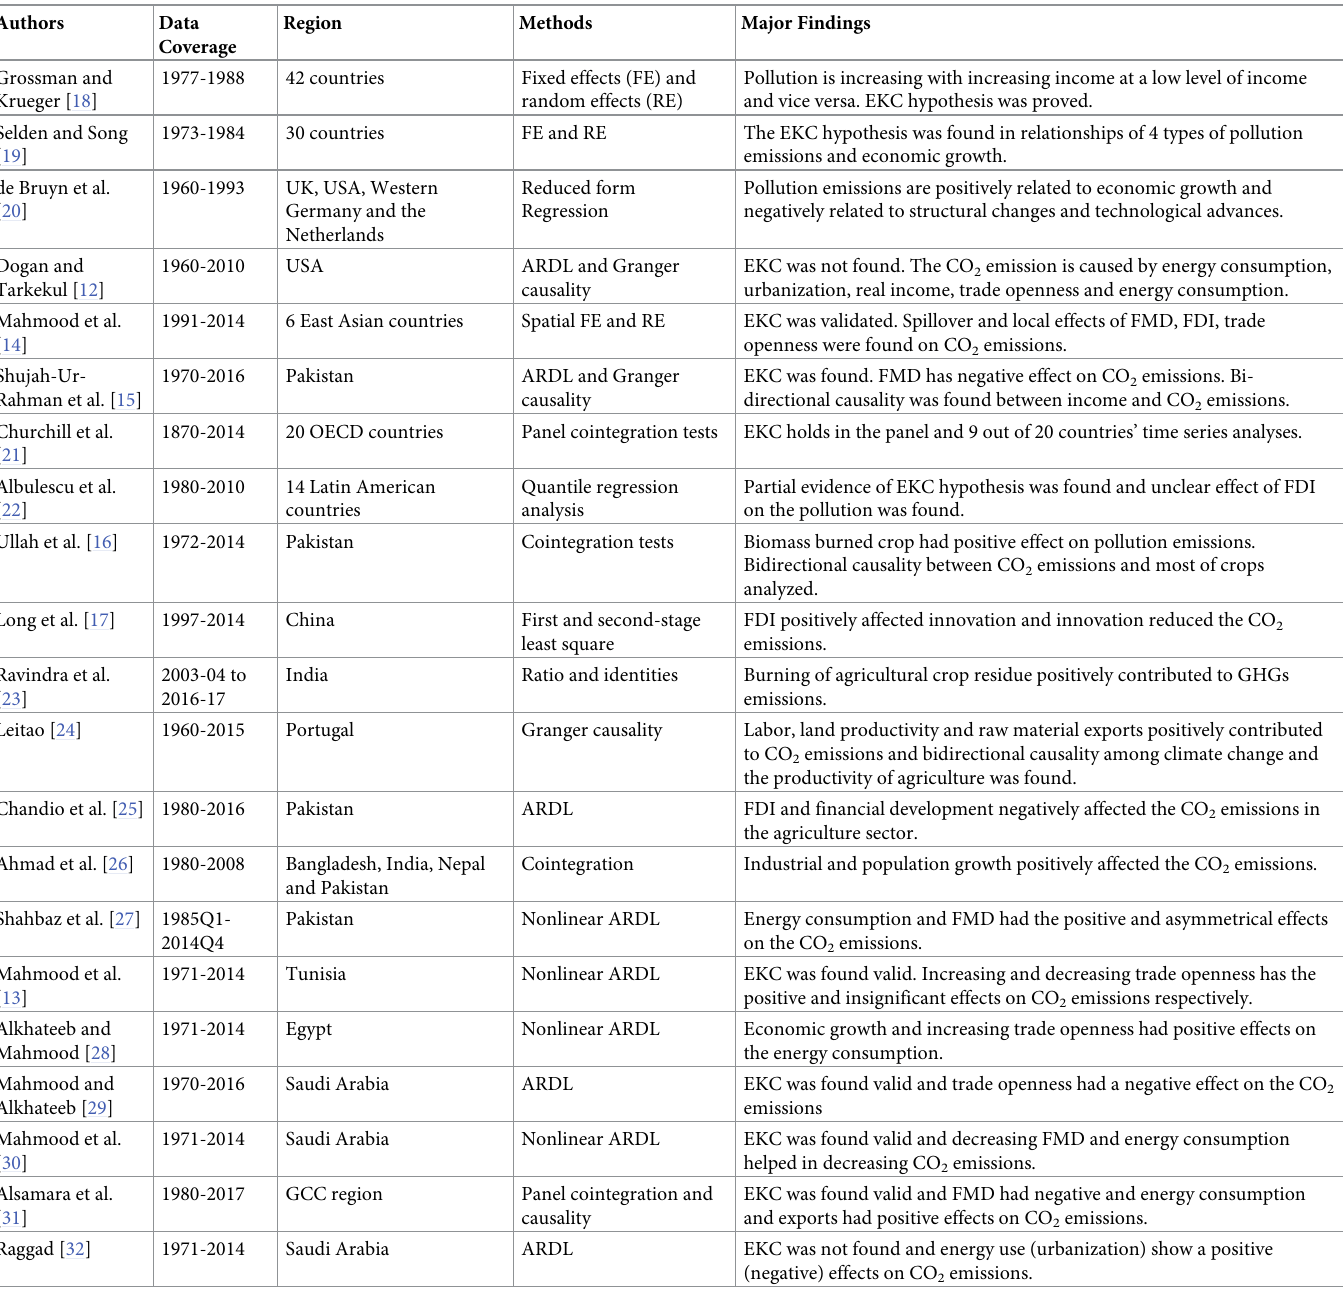
Table 1. Literature